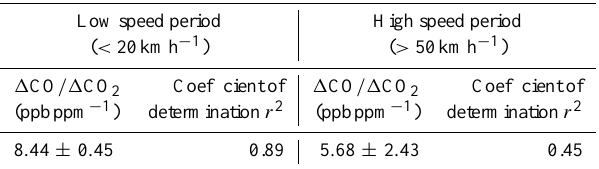
Table 5. (cid:49) CO to (cid:49) CO 2 ratios in the Thiais tunnel depending on average vehicle